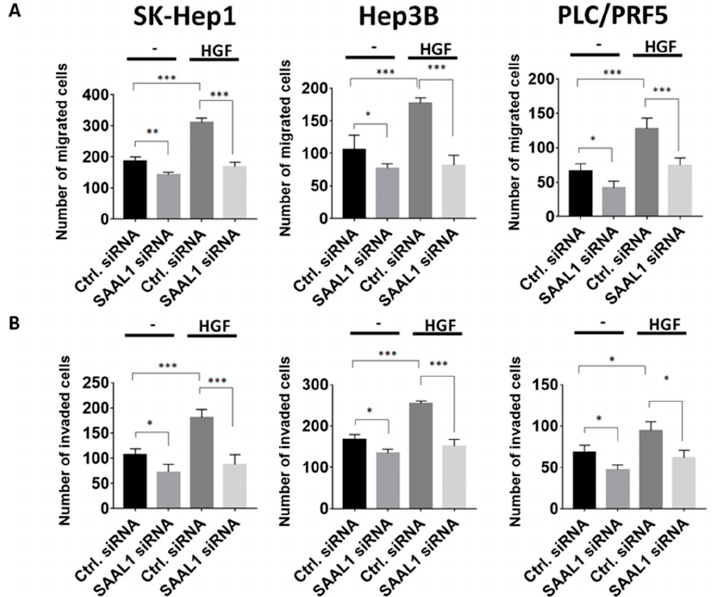
Figure 3. Inhibition of SAAL1 expression suppresses HGF-induced HCC cell migration and